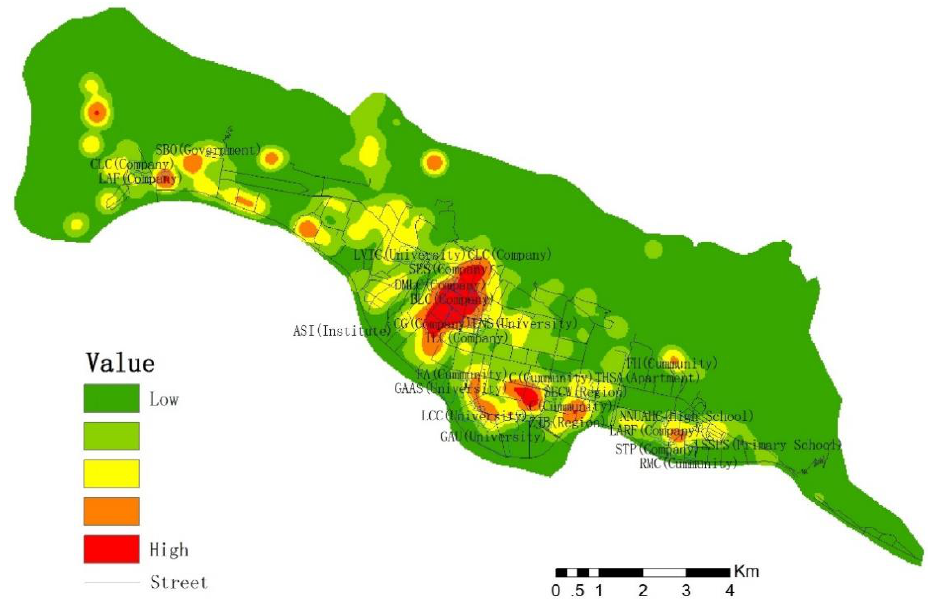
Figure. 6 Distribution of kernel density in color steel building’s